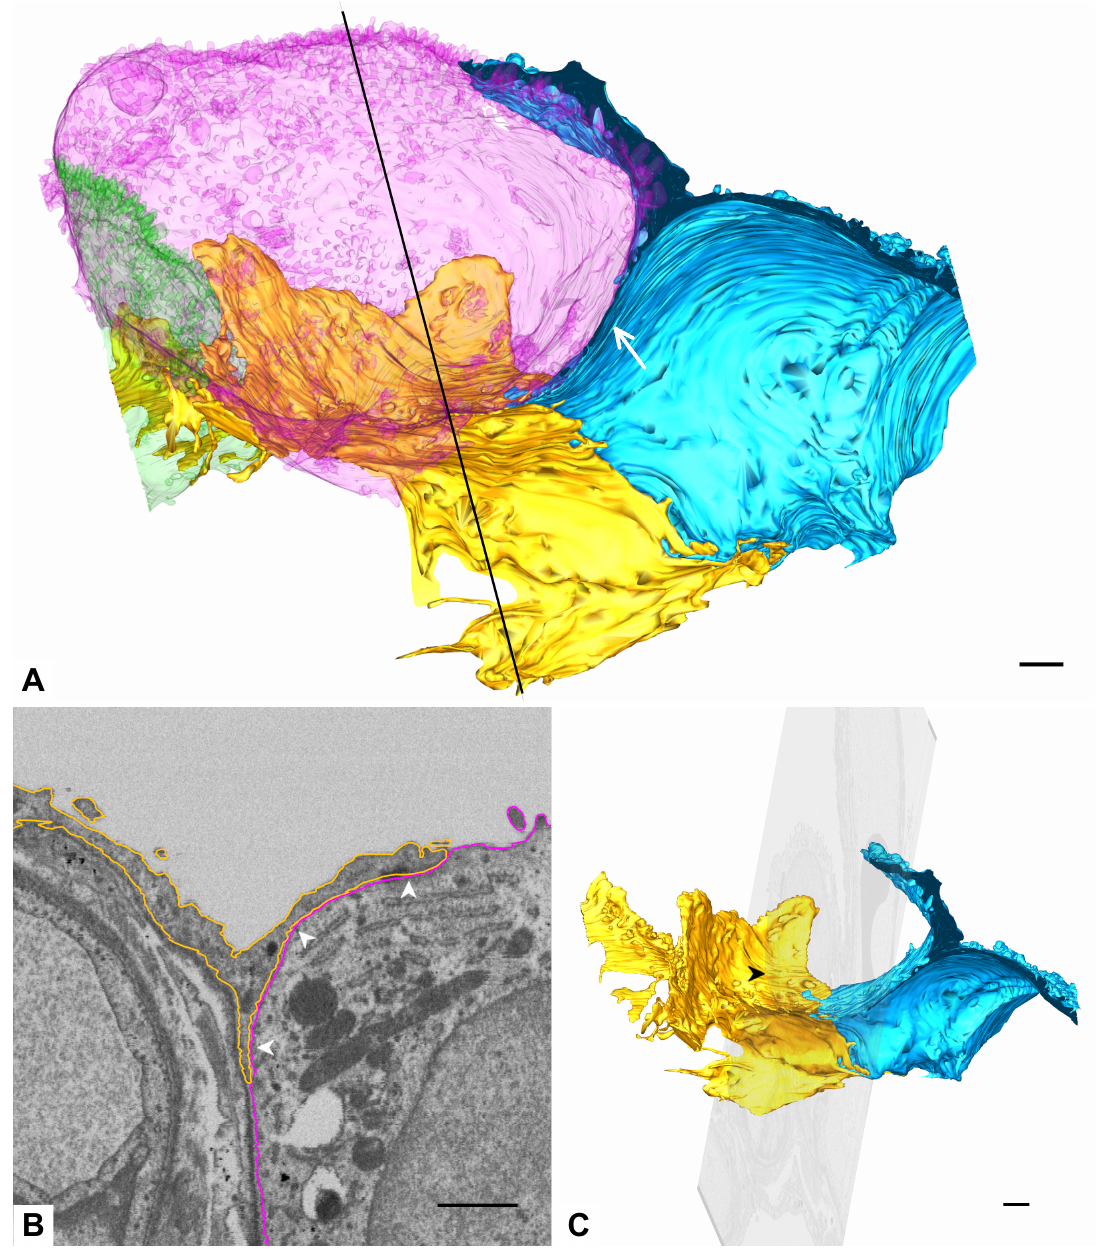
Figure 10. AE1/AE2 contact. ( A ) 3D model of the two AE1 cell domains and AE2 cells. AE2 cell models are transparent to enable visualization of the yellow AE1 cell domain behind the AE2 cells. AE1 cells may branch at the edge of an AE2 cell and extend their branches beneath and over the AE2 cell to form a bowl-like structure that enwraps the AE2 cell partially. The yellow AE1 cell domain forms a bowl at the edge of the pink AE2 cell (behind the transparent AE2 cell model). Note also the y-shaped branching of the blue AE1 cell domain and its extension beneath the pink AE2 cell (arrow). The black line indicates the position of the transect image in B. ( B ) Reconstruction of the y-plane (lateral view on the dataset) at the position indicated by the black line in A. The profiles of the yellow AE1 cell domain and the pink AE2 cell are indicated by yellow and pink outlines. Note the y-shaped profile of the yellow AE1 cell domain. The surface of the yellow AE1 cell domain (“inner surface” of the bowl) looked at in A and C is indicated by arrowheads. ( C ) 3D model of the yellow and blue AE1 cell domain transected by the y-plane shown in B. The different angle of view compared to A facilitates the imagination of a bowl formed by the yellow AE1 cell domain. The arrowhead indicates where the image plane transects the bowl of the yellow AE1 cell domain. Scale bars: 1 µ